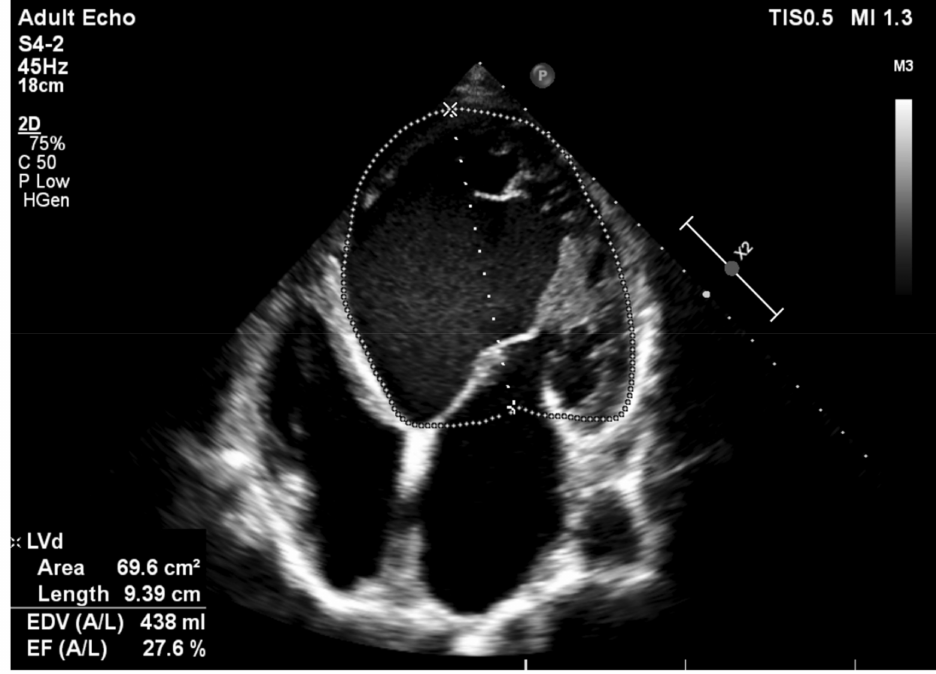
Figure 3. Transthoracic echocardiography—apical 4-chamber view: severe left ventricular dilation with markedly decreased ejection fraction in a 47-year-old subject with a history of long-term alcohol abuse (authors’ personal